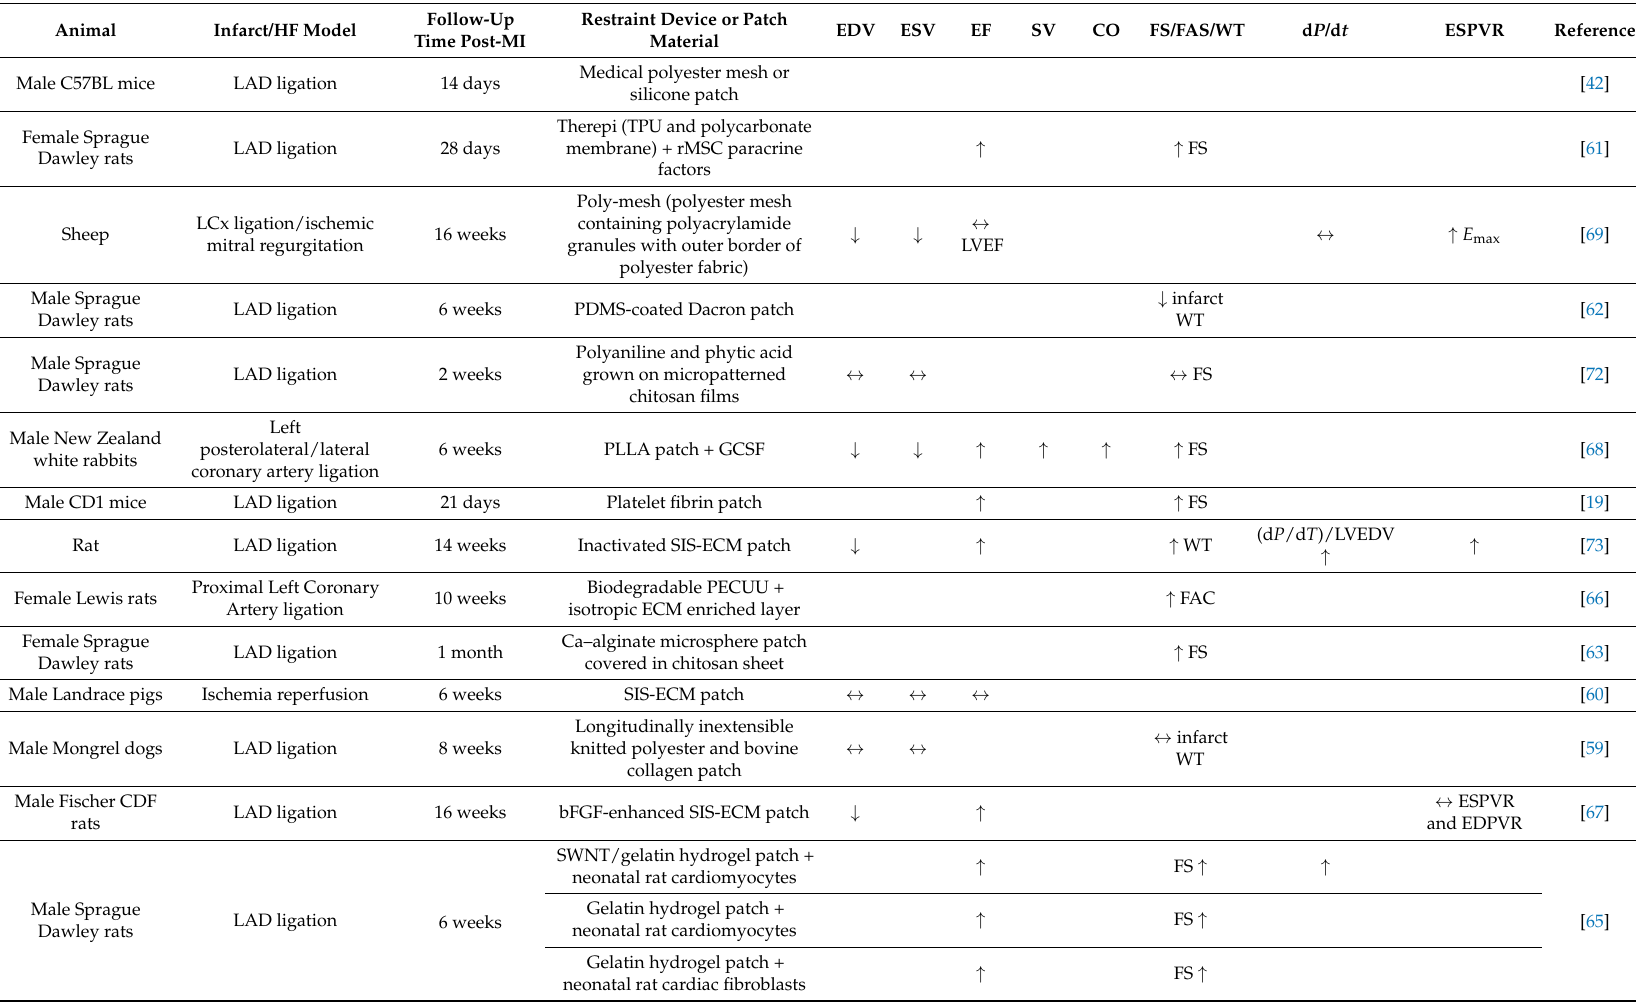
Table 2. Summary of chronic epicardial local reinforcement studies (those reviewed in [5] are not included).